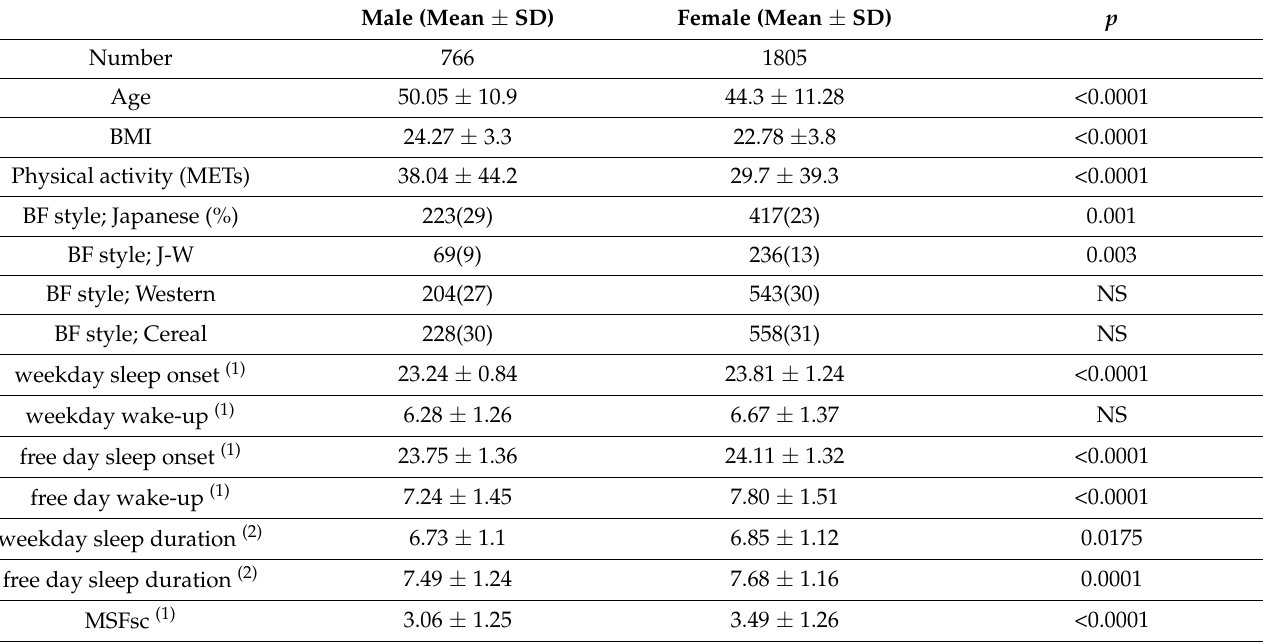
Table 1. Basic characteristics of